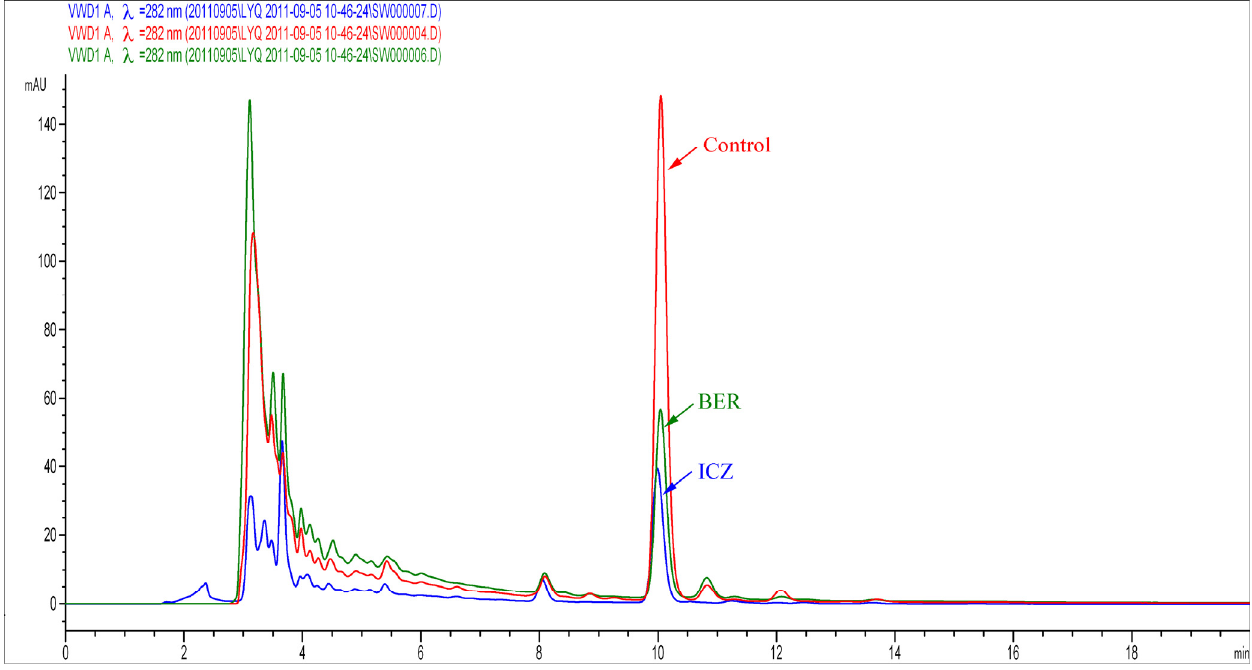
Figure 6. HPLC analysis of ergosterol in A. fumigates . Red was Control, green was BER, blue was